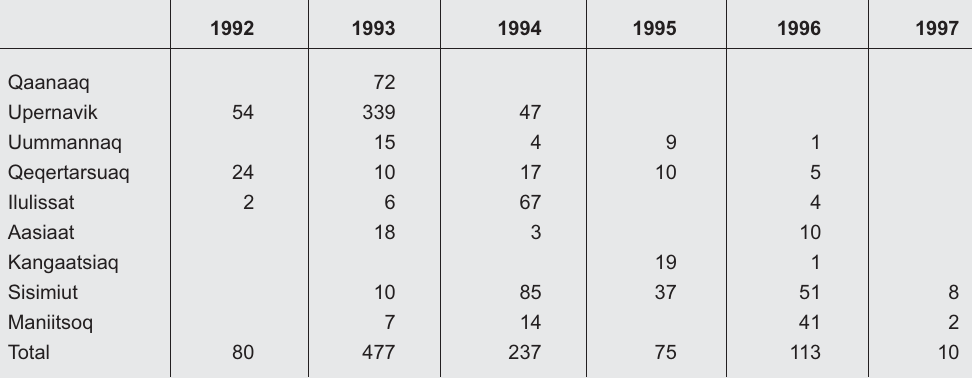
Table 6. Number of lower jaws from belugas that have been delivered since the obligatory jaw collection system was put in force in